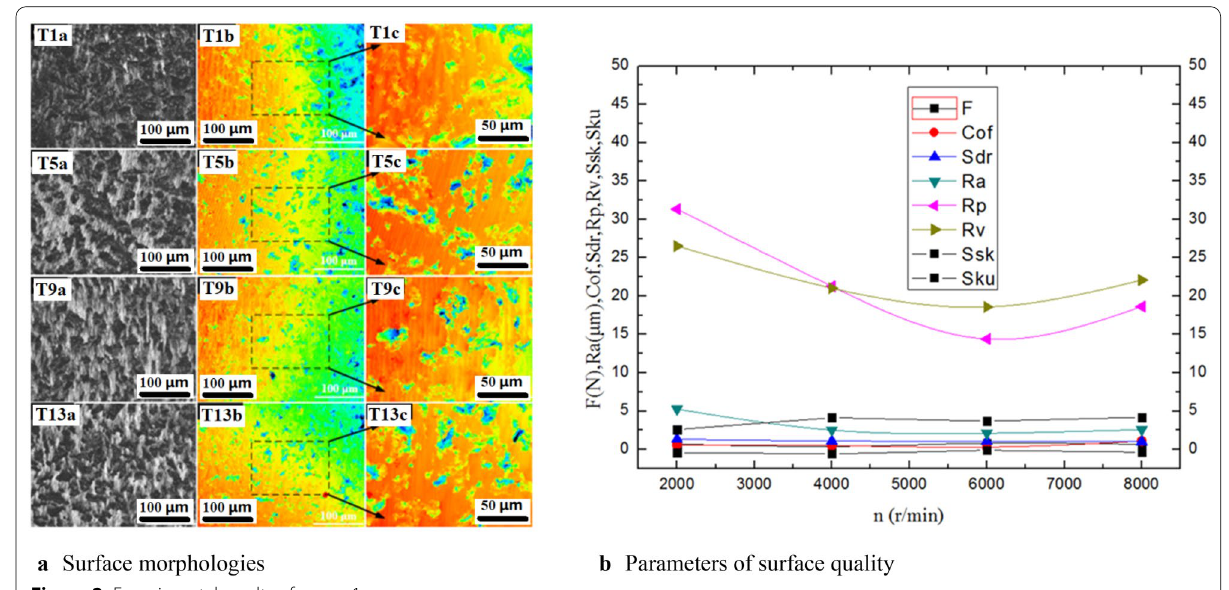
Figure 2 Experimental results of group 1